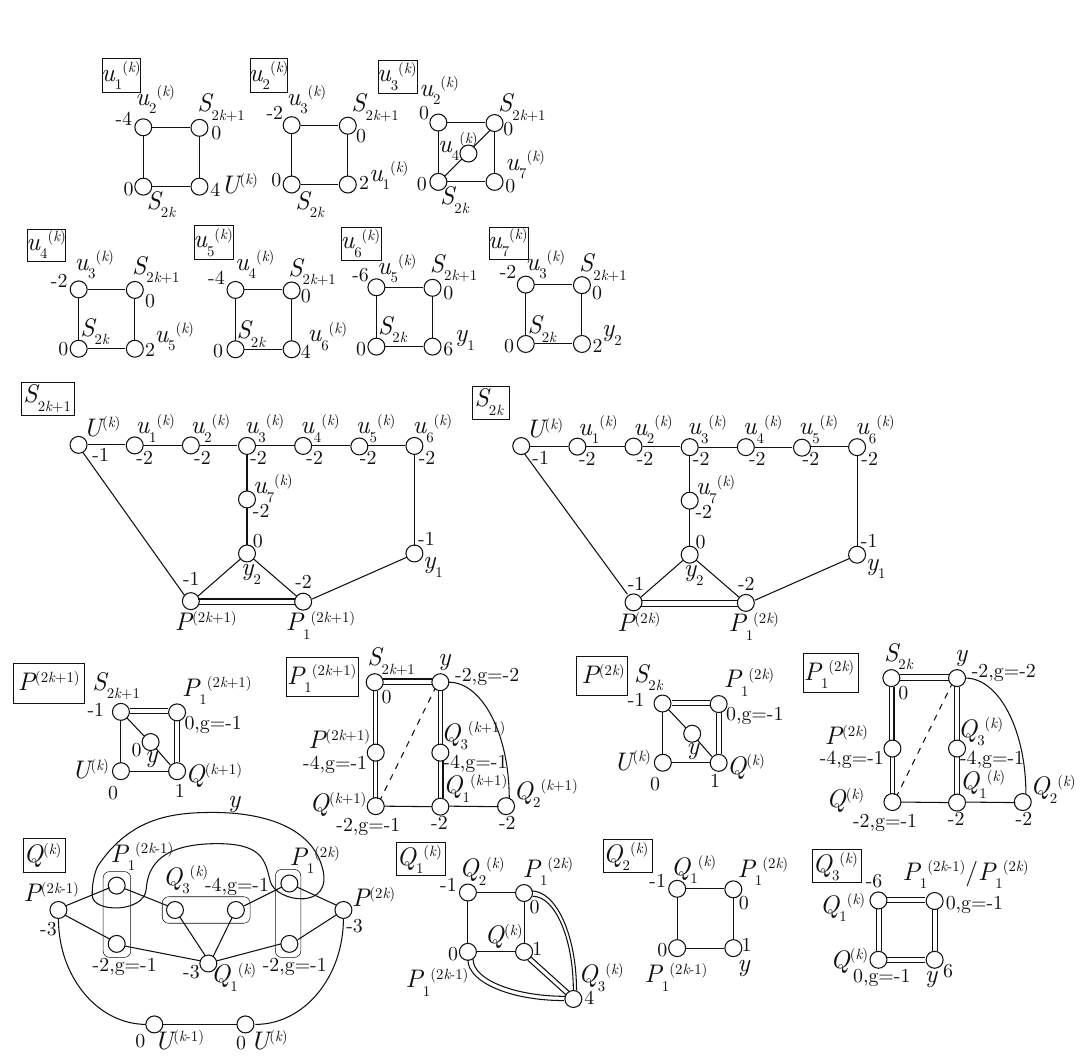
Figure 12. The con(cid:12)guration of curves in the (cid:13)opped geometry of non-minimal ( E 7 ; E 7 ) conformal matter with order N . Dotted line means negative intersection